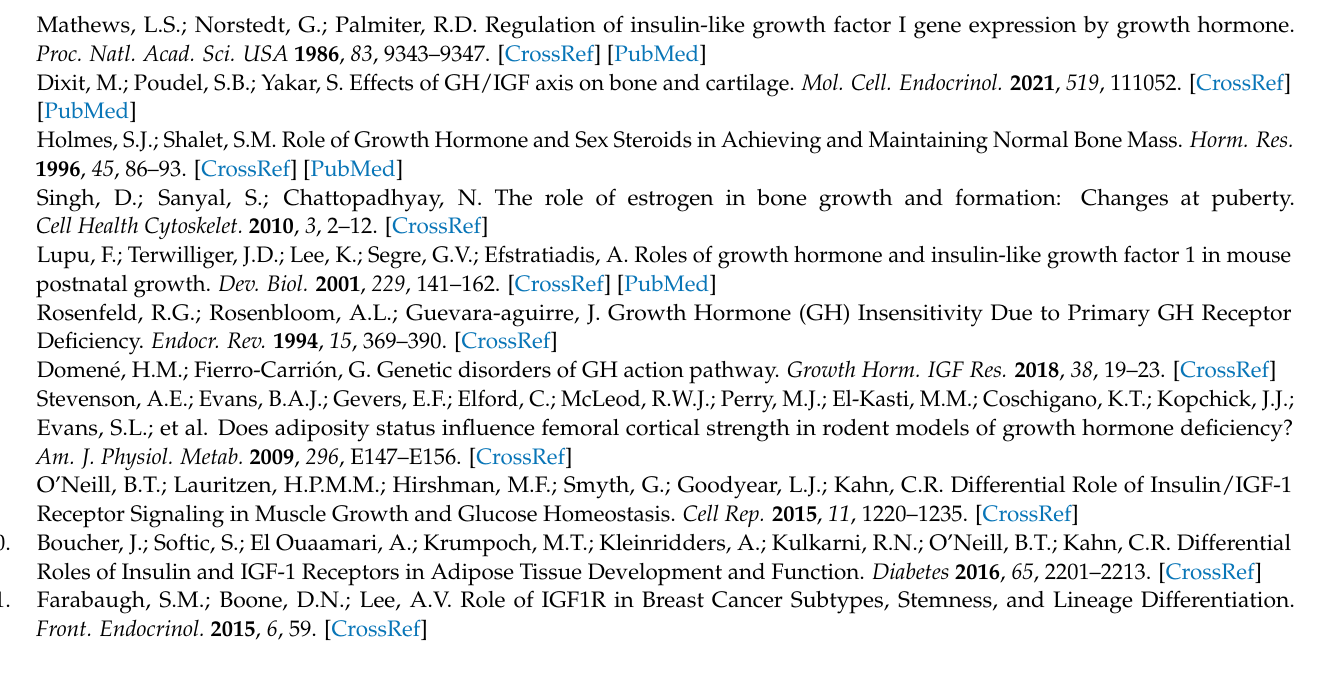
this study. Table S2. Assemble information for the GH, GHR, IGF1 and IGF1R genes from the 16 pig genomes. Table S3. The information of sequences used for conservation analysis for the GH, GHR, IGF1 and IGF1R genes. Table S4. Primers for RIPs detection and GHR promotor and GHR-RIP10 clone. Table S5. The detail information of structure variations in GH, GHR, IGF1 and IGF1R genes. Supplementary file 1. The sequences of GH, GHR, IGF1 and IGF1R genes from the pig genomes in fasta